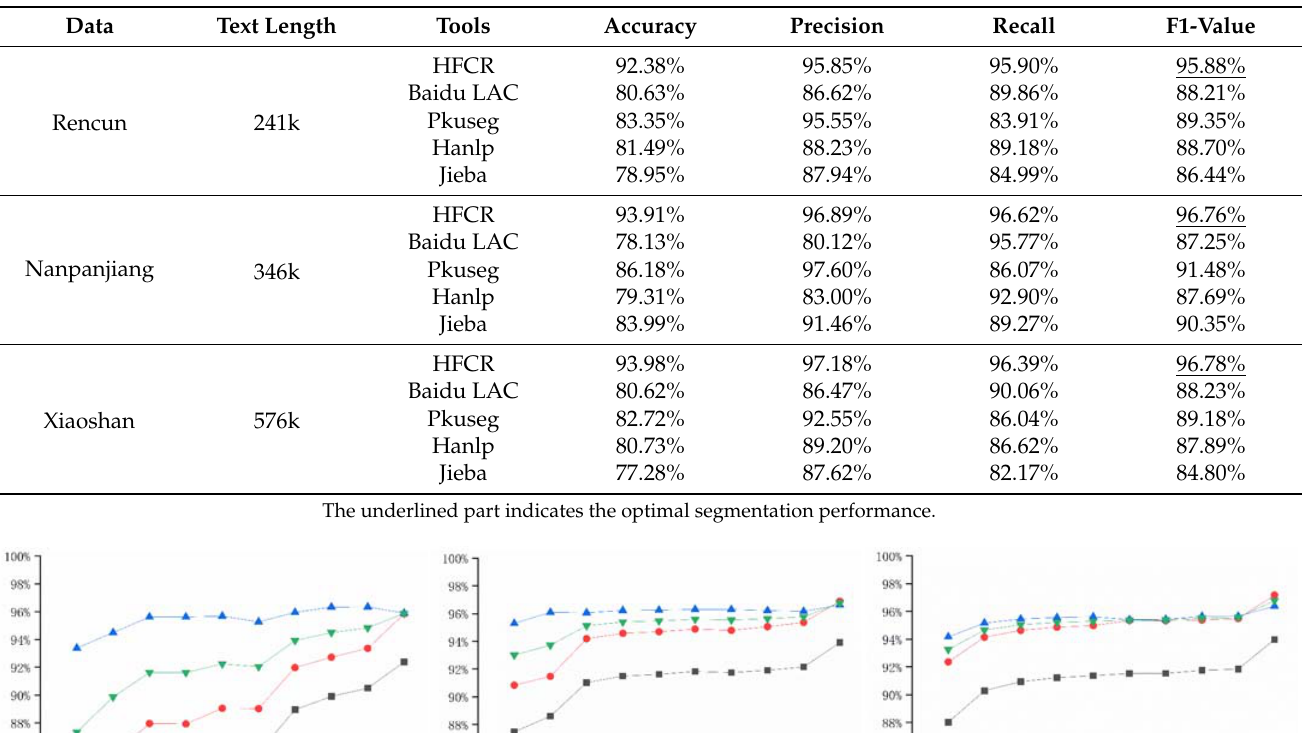
Table 3. Comparison of accuracy between HFCR algorithm and other tokenizers (geological text).